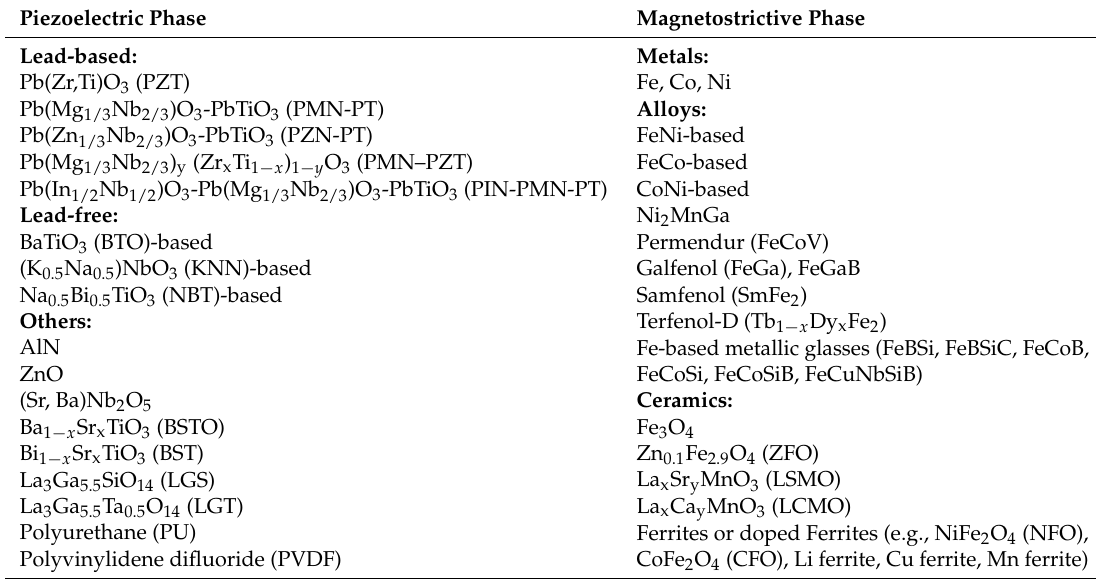
Table 1. List of well-known piezoelectric and magnetostrictive materials used as constituents of ME